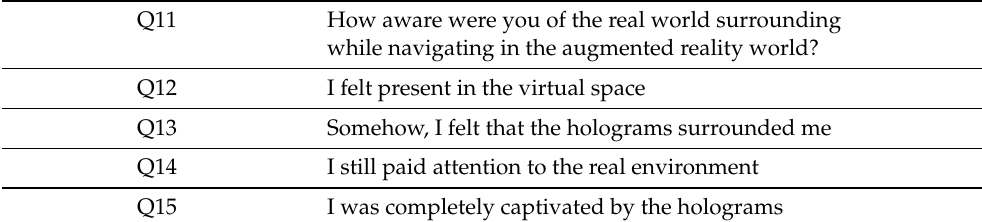
Table 2. Selected questions from the IPQ questionnaire